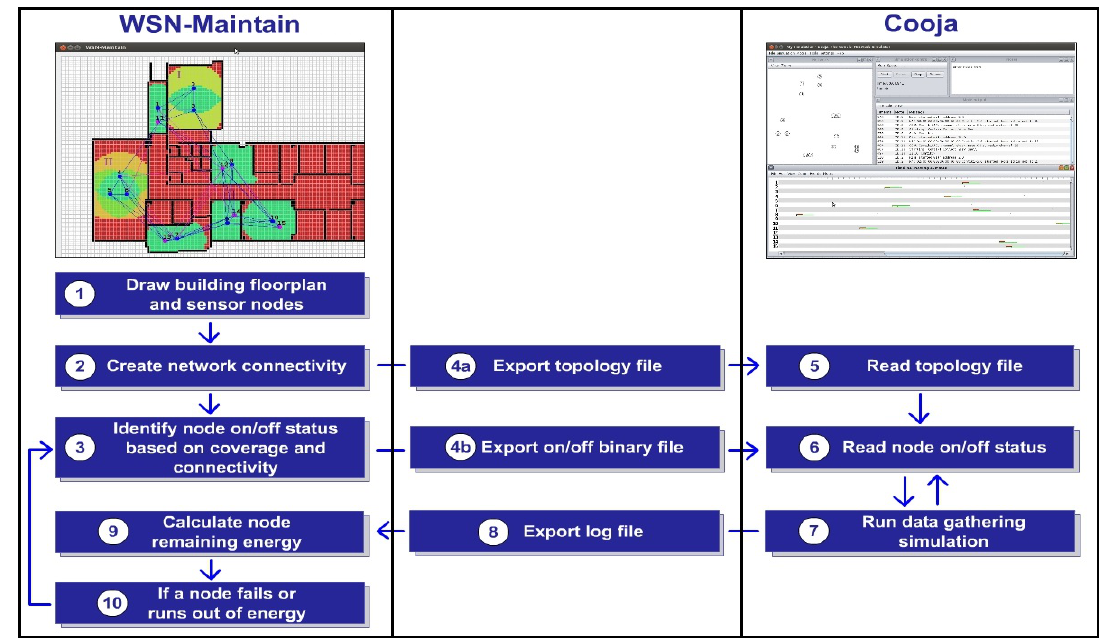
Figure 1. WSN-Maintain and Cooja